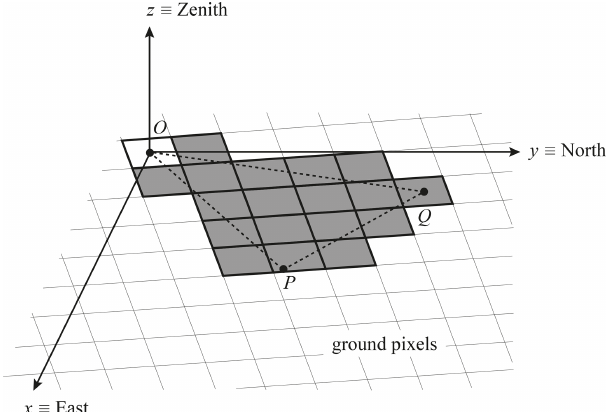
Figure 3. Sketch of the PCSF flagging of the TROPOMI ground pixels in the local reference frame at the Earth’s surface. The PCSF pixels are indicated in grey, and the cloud pixel is indicated by the white quadrilateral. Points O, P, and Q correspond to points O, P, and Q in Fig.